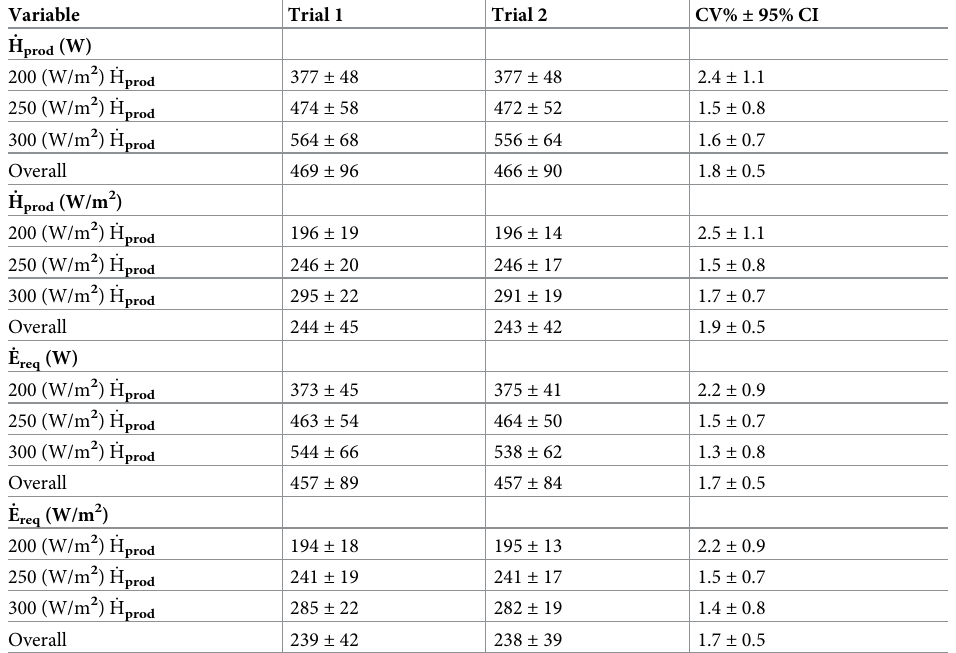
Table 4. Mean, standard deviation and reliability of partitional calorimetry variables (H˙ prod and E˙ req ) at a range of exercise intensities.